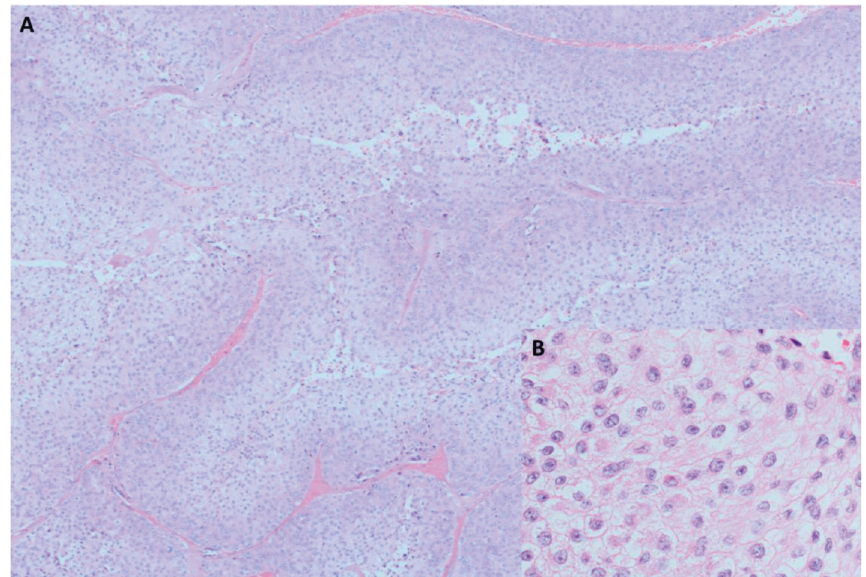
Figure 4: Photomicrographs of right adrenal tumor of Patient A on pathology review. (a) Diffuse growth pattern (H&E × 40). (b) Regular nuclei and eosinophilic cytoplasm of tumor cells (H&E ×